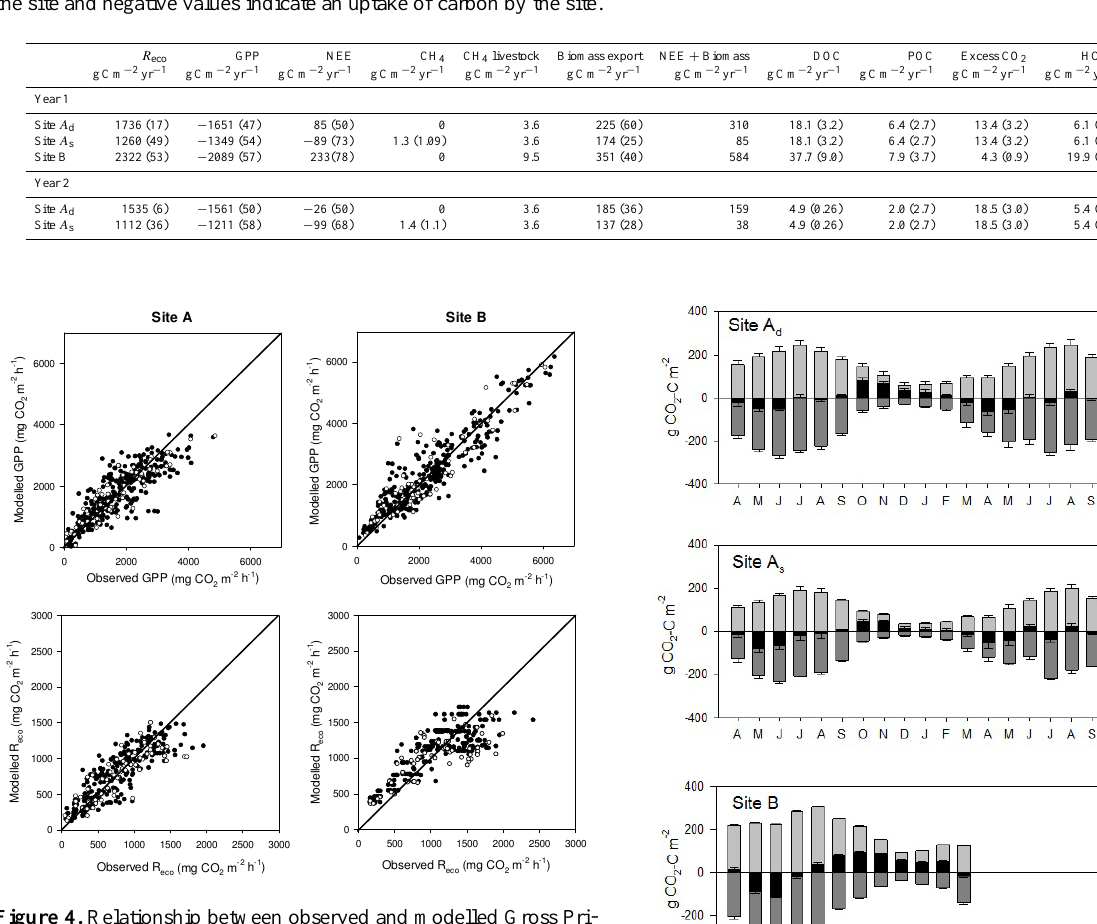
Table 4. Annual fluxes of ecosystem respiration ( R eco ) , gross primary production (GPP), net ecosystem exchange (NEE) of CO 2 , CH 4 , dissolved organic carbon (DOC), particulate organic carbon (POC), excess CO 2 and bicarbonate (HCO − CH 4 emissions from enteric fermentation and net ecosystem carbon balance (NECB). Standard errors are shown in parentheses for all gas fluxes R eco , GPP, NEE and for fluvial fluxes. One standard deviation is shown in parentheses for all other components. Site A d = nutrient- poor deep-drained, Site A s = nutrient-poor shallow-drained and Site B = nutrient-rich drained. Positive values indicate a loss of carbon from the site and negative values indicate an uptake of carbon by the site.